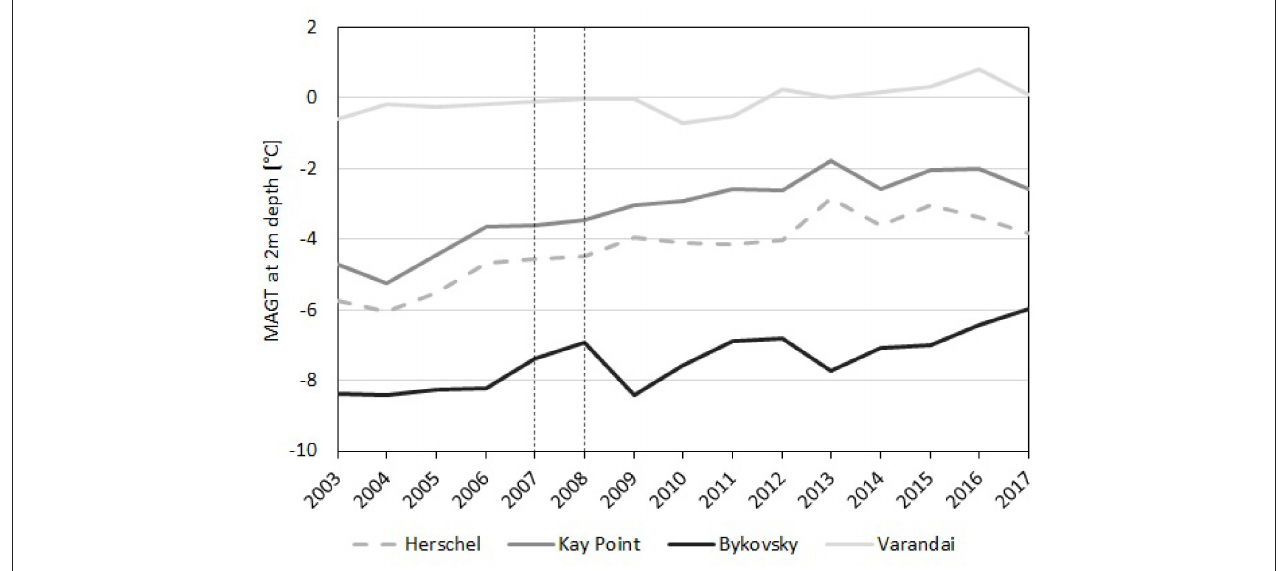
FIGURE 10 | Mean annual ground temperature (MAGT) at 2 m depth for 2003–2017 (source: Obu et al., 2019a). Vertical dashed lines indicate years with PALSAR acquisitions.